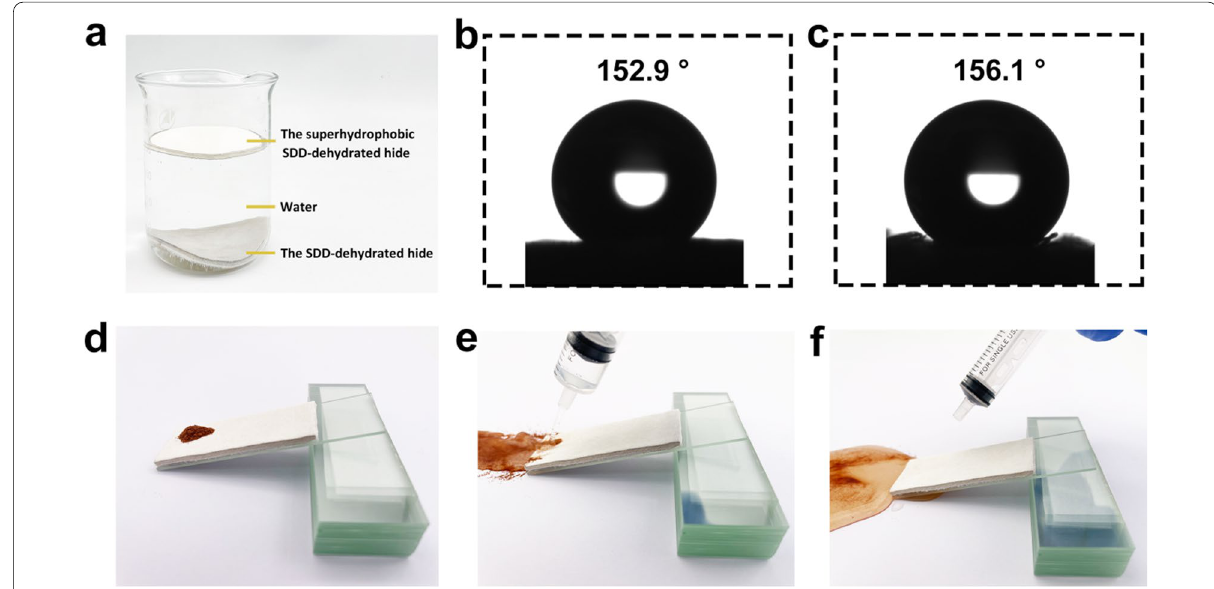
Fig. 6 ( a ) Digital photo showing the SDD-dehydrated hide sinking in water and the superhydrophobic SDD-dehydrated hide floating on water, digital photos showing the water contact angle of ( b ) grain surface and ( c ) flesh surface of the superhydrophobic SDD-dehydrated hide, ( d–f ) digital photos showing the self-cleaning ability of the superhydrophobic SDD-dehydrated